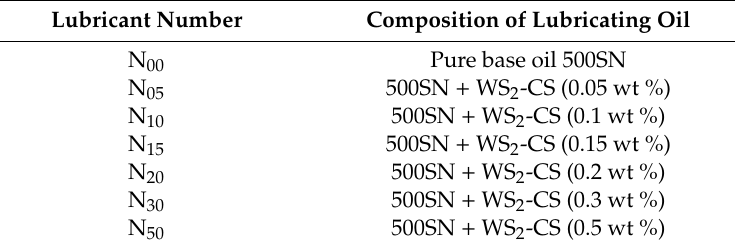
Table 4. Lubricating oils with di ff erent additive